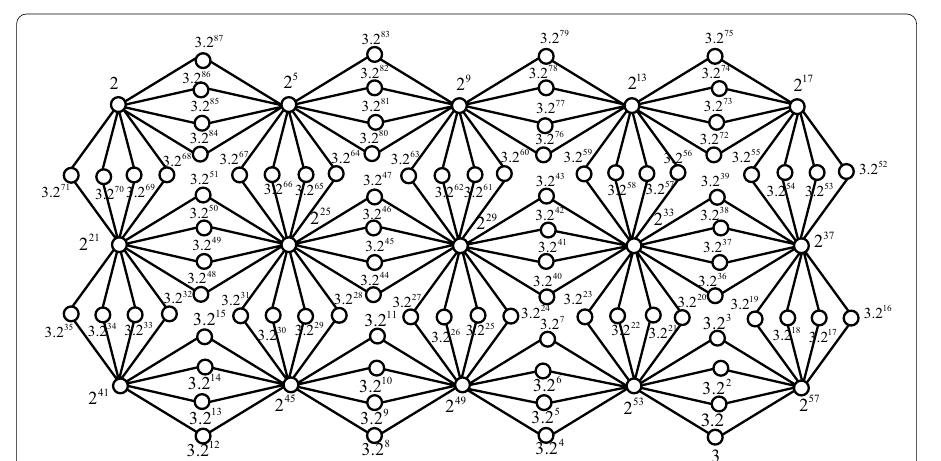
Fig. 7 15-Zumkeller labeling of SSD ( CL 4